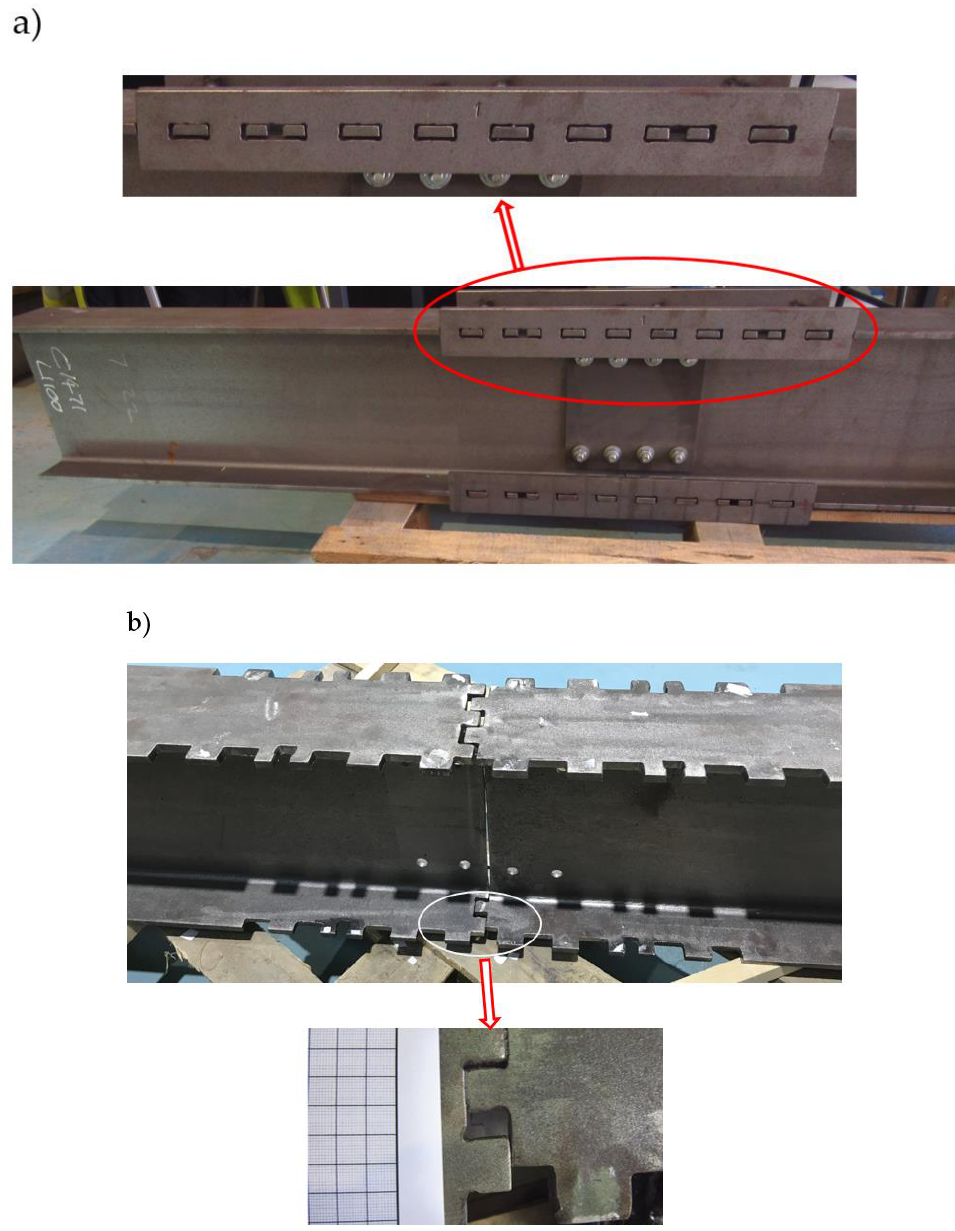
Figure 13. Beam test-B cutting accuracy. ( a ) overall image; ( b ) close-up.